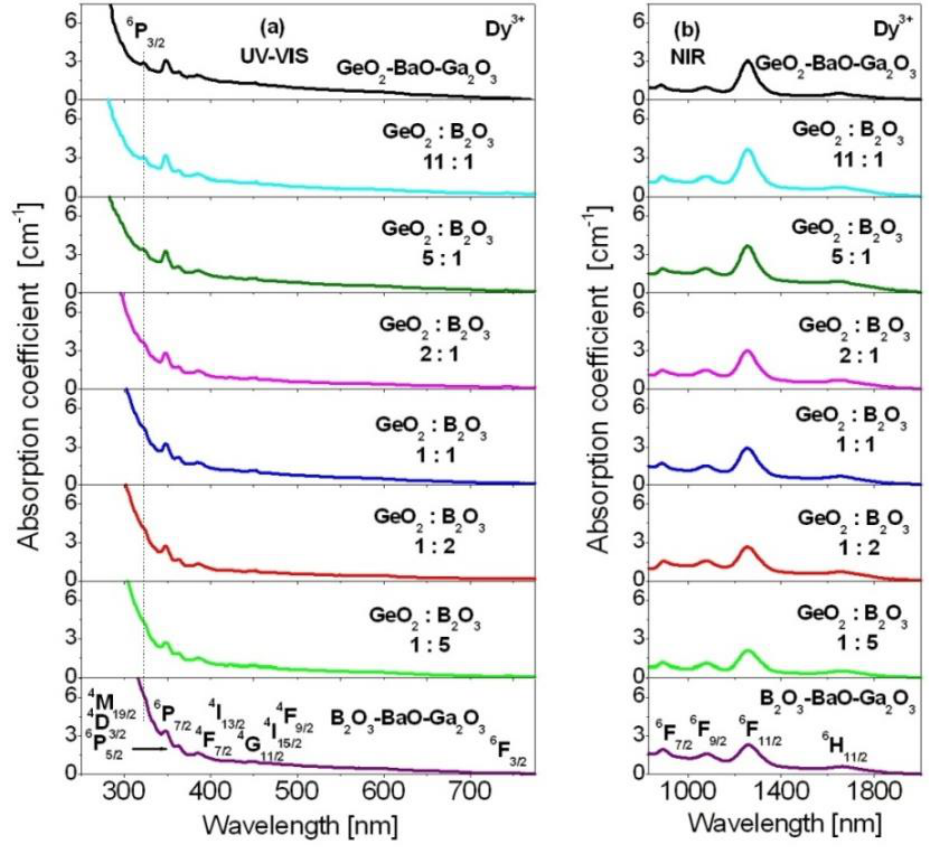
Figure 2. Absorption spectra for Dy 3+ ions in borogermanate glasses with various molar ratios GeO 2 :B 2 O 3 compared to GeO 2 -BaO-Ga 2 O 3 and B 2 O 3 -BaO-Ga 2 O 3 glasses. The spectra were measured